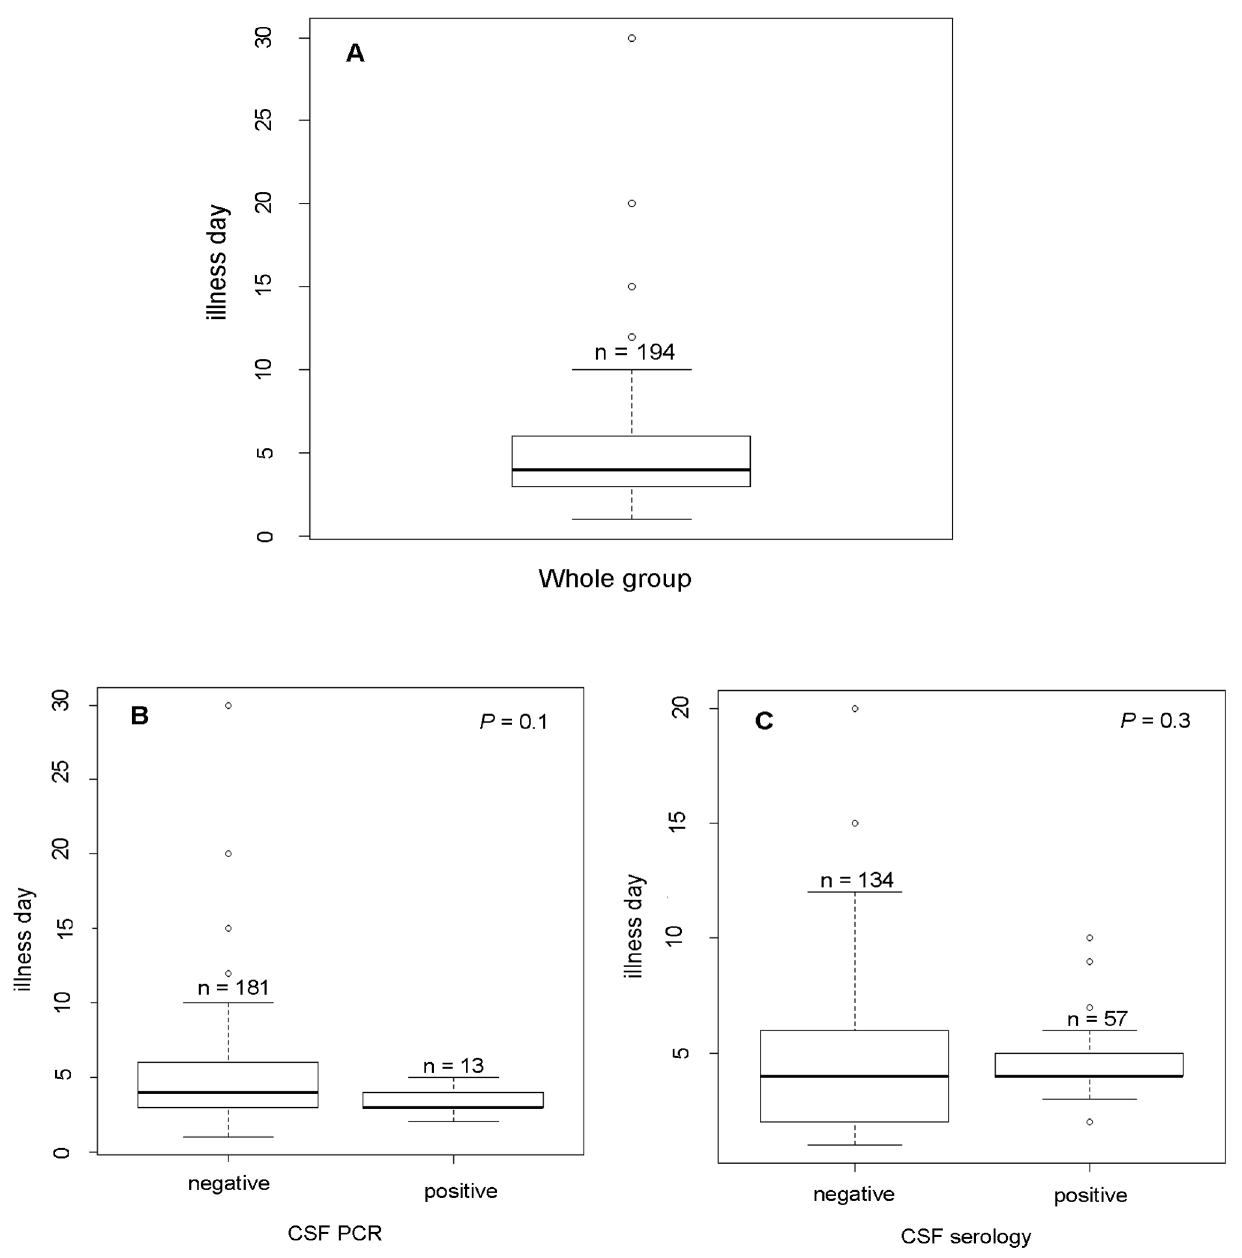
Figure 1. Illness day on admission Vs CSF PCR and serology. A, whole group; B, comparison of illness day on admission of viral PCR negative and viral PCR negative group; C, CSF serology negative and CSF serology positive